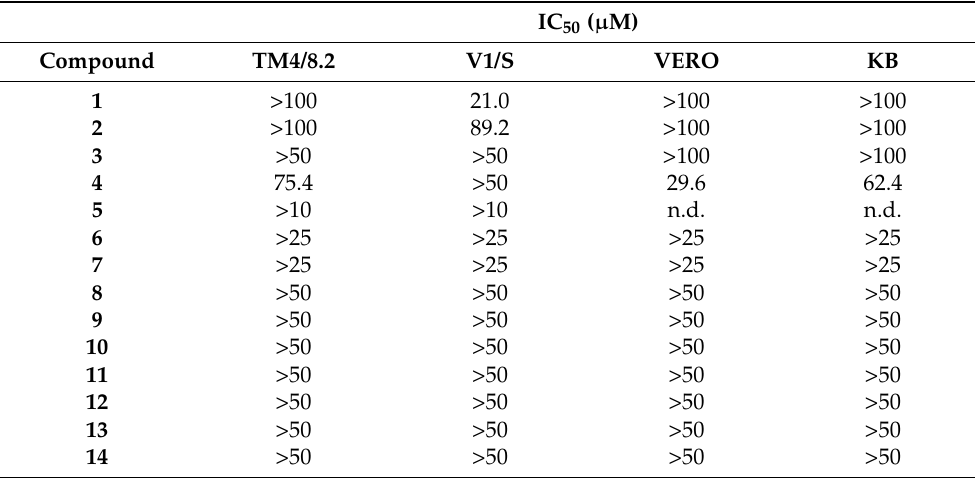
Table 4. IC 50 values on Plasmodium falciparum strains TM4/8.2 (drug sensitive) and V1/S (drug resistant) and VERO and KB mammalian cell